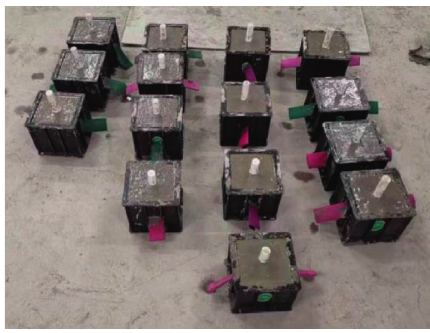
Figure 3: Production of specimens.